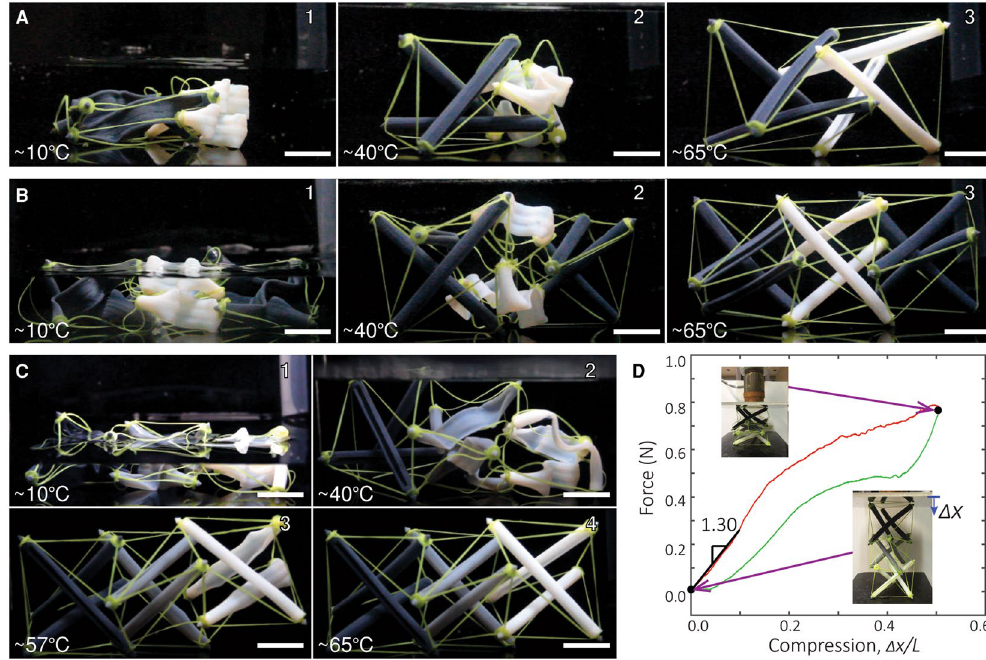
Figure 4. Programmed deployment of layered tensegrity structures. ( A ) Programmed deployment sequence of the 2-layer tensegrity using 2 different SMPs for the struts [DM-1 (the dark grey material) and BM (the white material)]. ( B ) Programmed deployment sequence of the 3-layer tensegrity using 2 different SMPs for the struts [DM-1 (the dark grey material) and BM (the white material)]. The two end layers have struts made with SMP of a lower T g than the middle layer. ( C ) Programmed deployment sequence of the 3-layer tensegrity using 3 different SMPs for the struts. The three SMPs have increasing T g ’s from left to right. The darker the color, the lower the T g . ( D ) Compression test of the deployed 3-layer tensegrity made with 3 different SMPs. The test reveals a maximum compression in the struts around 0.12 N. The scale bars represent 15